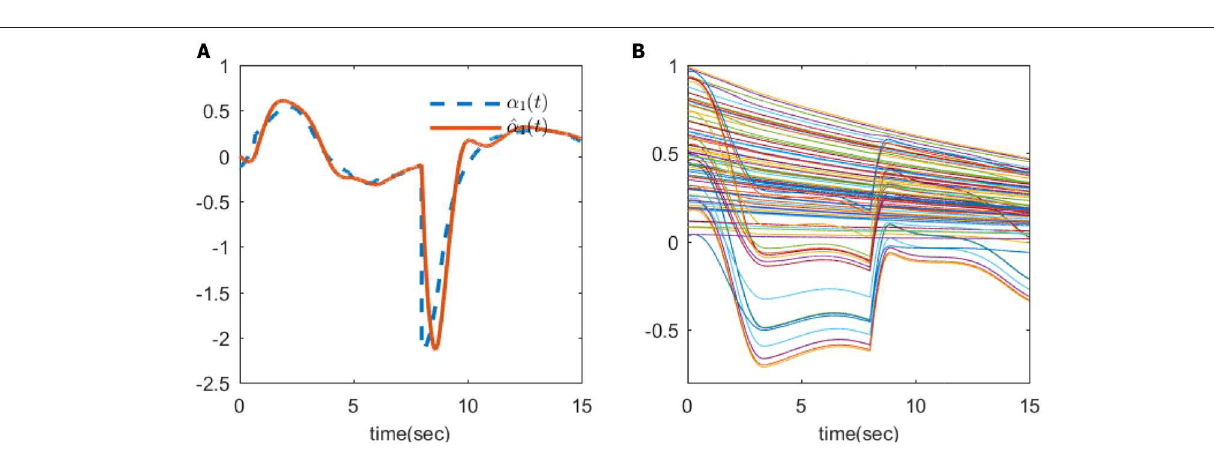
FIGURE 3 | Virtual input and NN parameters in (A) virtual inputs α 1 ( t ) and α 2 ( t ); (B) NN